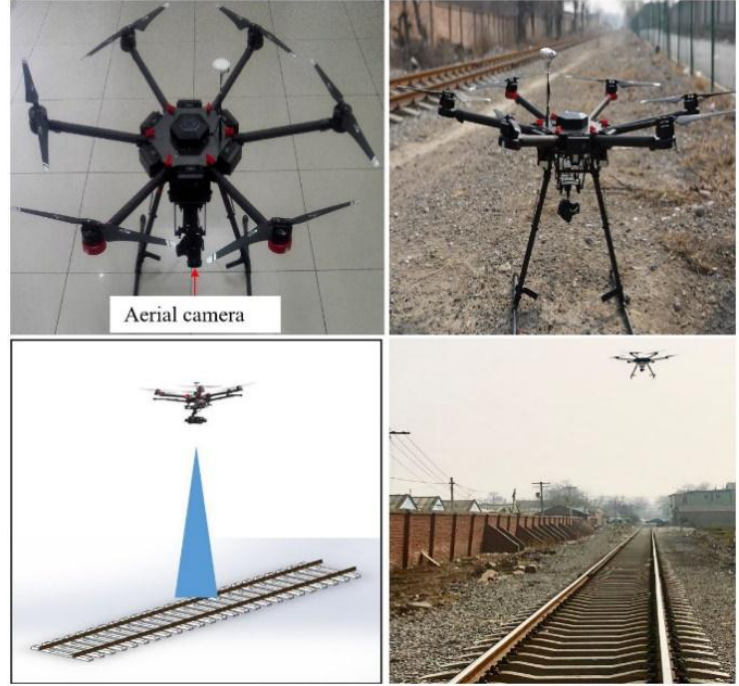
Figure 8. Experiment environment.